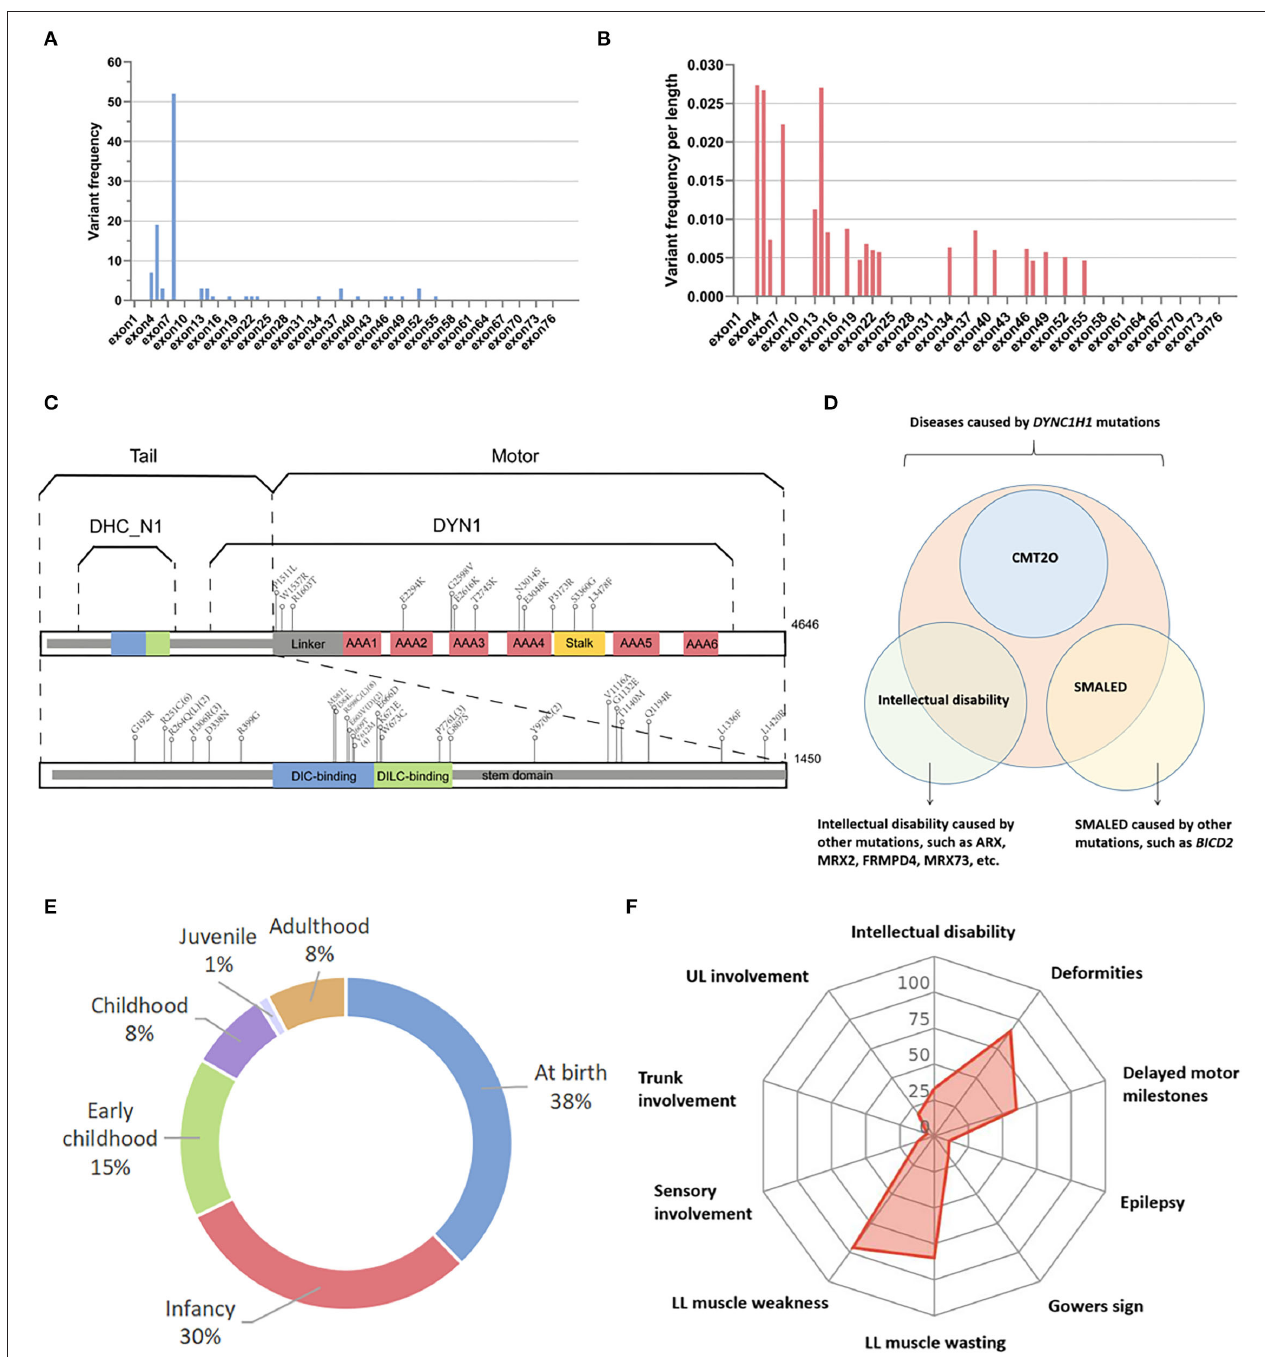
FIGURE 2 | Genetic and phenotypic spectrum of neuromuscular diseases caused by DYNC1H1 mutations. (A) DYNC1H1 variants on different exons not adjusting for exon length. (B) DYNC1H1 variants on different exons adjusting for exon length by calculating variant amounts per length. (C) Structural model of DYNC1H1 protein and relevant mutation sites in previous publications associated with neuromuscular diseases; the numbers in brackets indicate the recurrent times of mutations in different pedigrees; (D) Relationship between SMALED1, CMT2O, and DYNC1H1 mutations. (E) Distribution of disease onset age of patients with neuromuscular diseases caused by DYNC1H1 mutations; (F) Radar chart shows the percentage of some common features of DYNC1H1- related neuromuscular diseases. AAA, ATPase family associated with various cellular activities; ARX, aristaless-related homeobox; BICD2, BICD cargo adaptor 2; CMT2O, Charcot–Marie tooth type 2O; DIC, dynein intermediate chain; DILC, dynein intermediate light chain; DLL, distal lower limbs; FRMPD4, FERM, and PDZ domain containing 4; LL, lower limbs; PLL, proximal lower limbs; SMALED, spinal muscular atrophy with lower extremity predominance; UL, upper limbs.